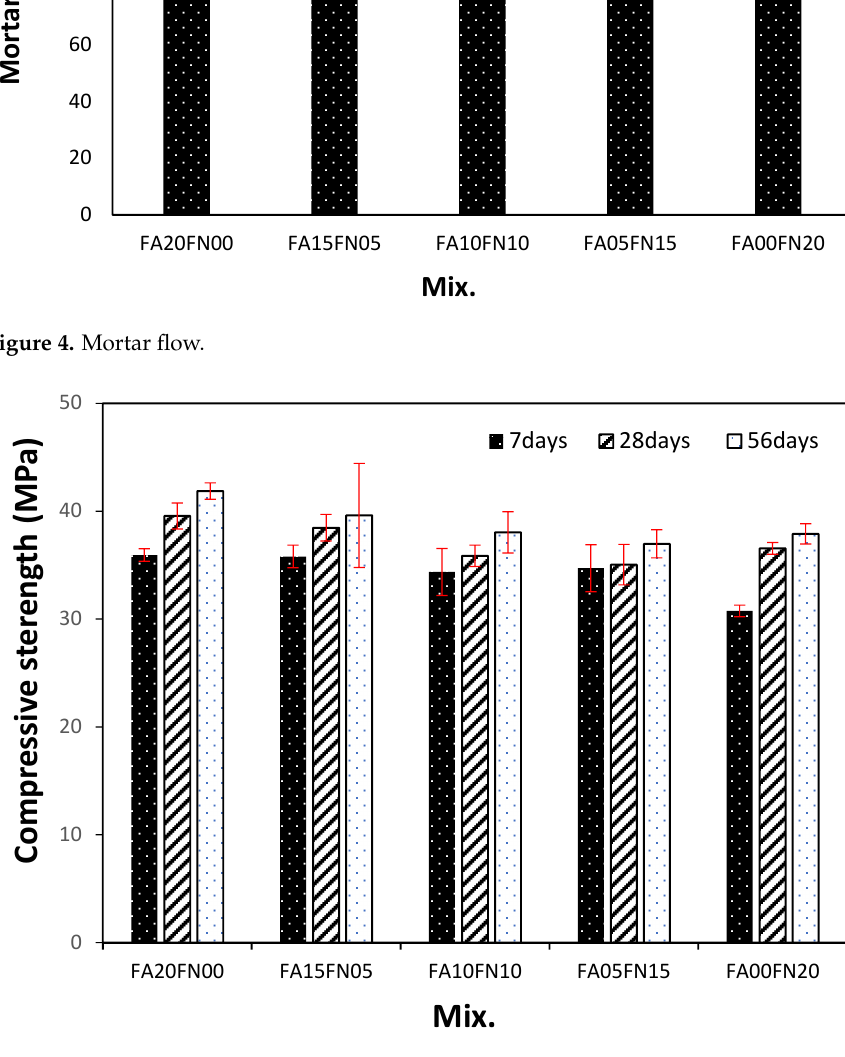
Figure 5. Compressive strength.